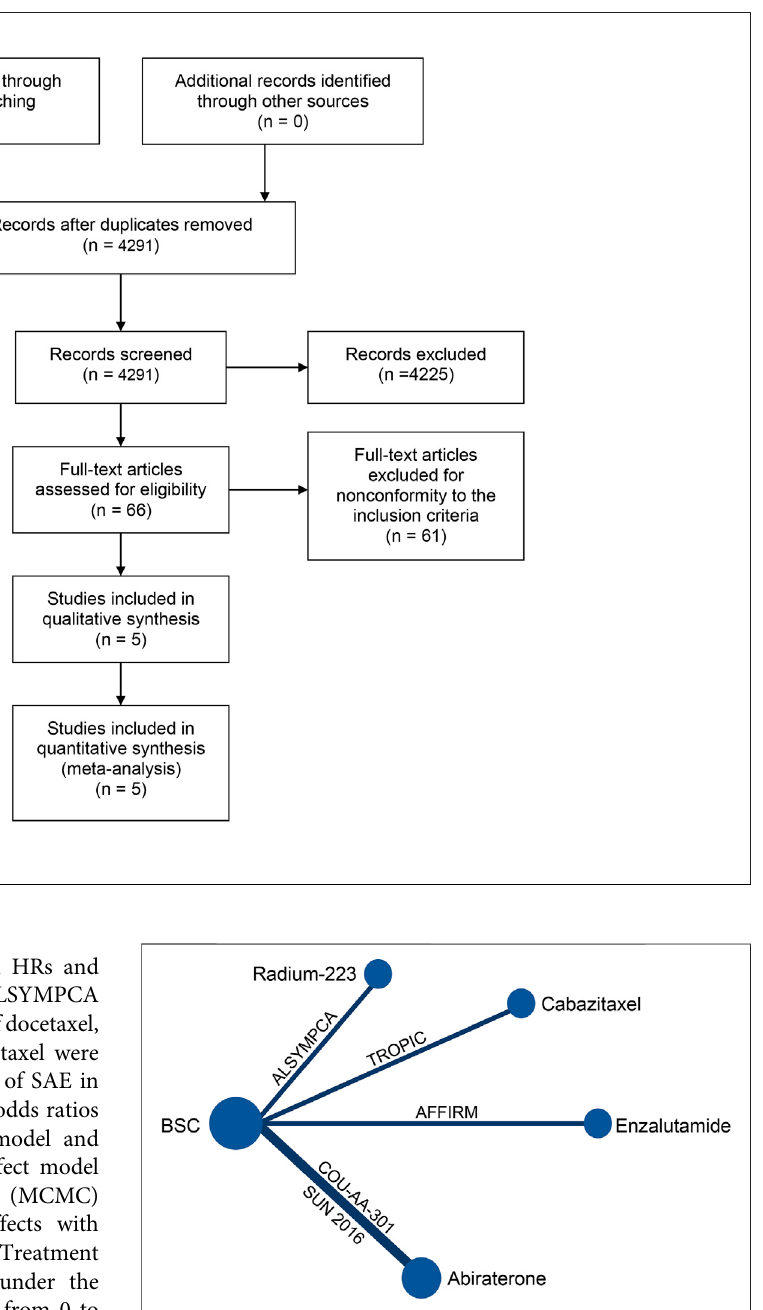
FIGURE 2 | Network plot of treatment